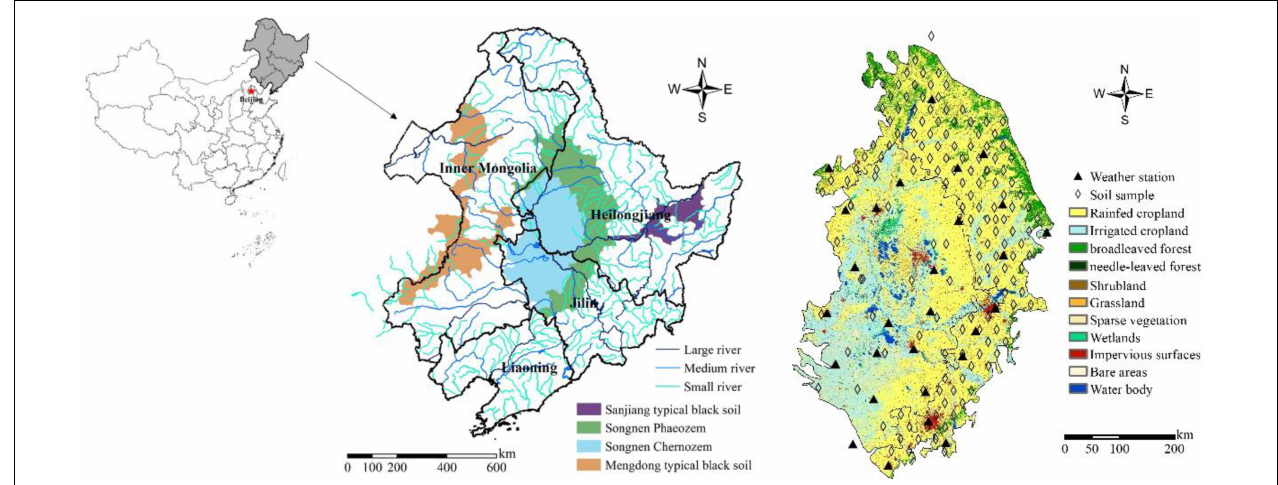
FIGURE 1 | Distribution of phaeozem, chernozem and rivers in Northeast China (left) ; distribution of 30 m-resolution land cover type, meteorological stations and soil sampling points in Songnen Plain in 2020 (right) .